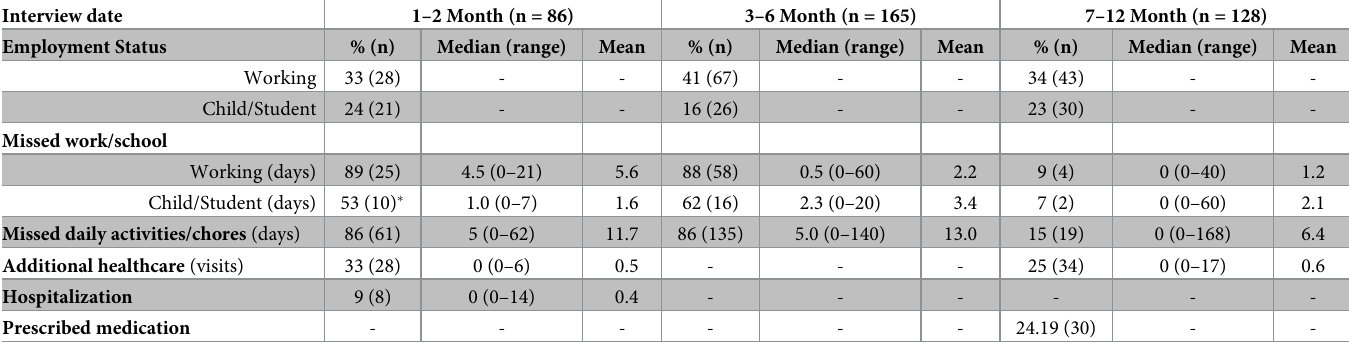
Table 1. Percentage of laboratory-positive cases 1–2, 6, and 12 months after disease onset who missed work, daily activities/chores, sought additional healthcare, were hospitalized due to chikungunya (CHIKV) illness and prescribed medication for CHIKV, U.S. Virgin